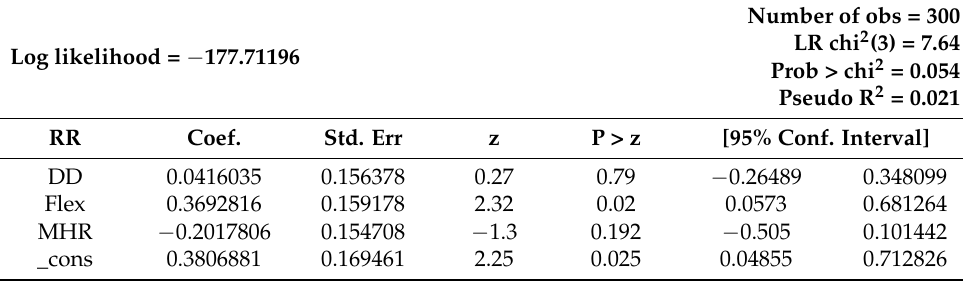
Table 4. Probit regression analysis with RR as dependent variable.